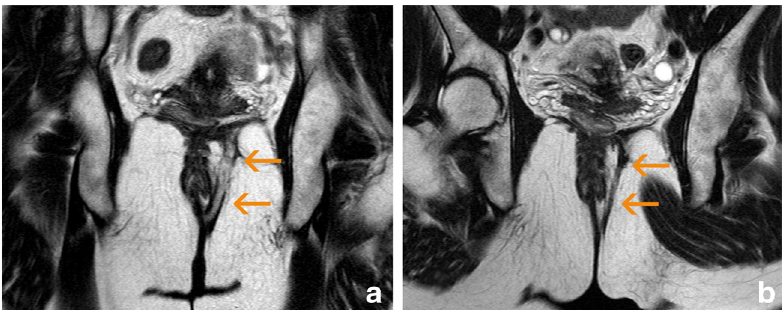
Fig. 8 Complete response after anti-TNF therapy. a Axial T2-weighted sequences at baseline show a complex left trans-sphincteric fistula with hyperintense paths (arrow); b Axial T2-weighted sequences after